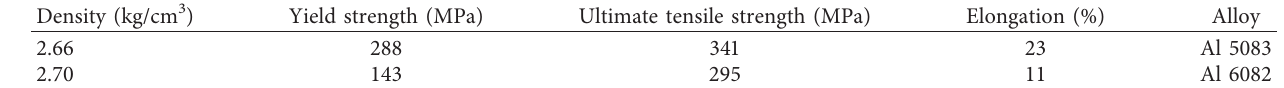
Table 2: Mechanical properties of aluminum alloys.